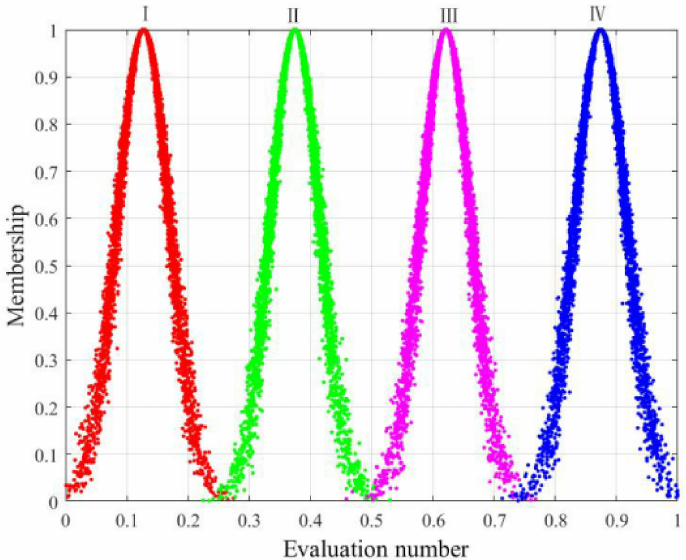
Figure 5. Comprehensive standard cloud model for total